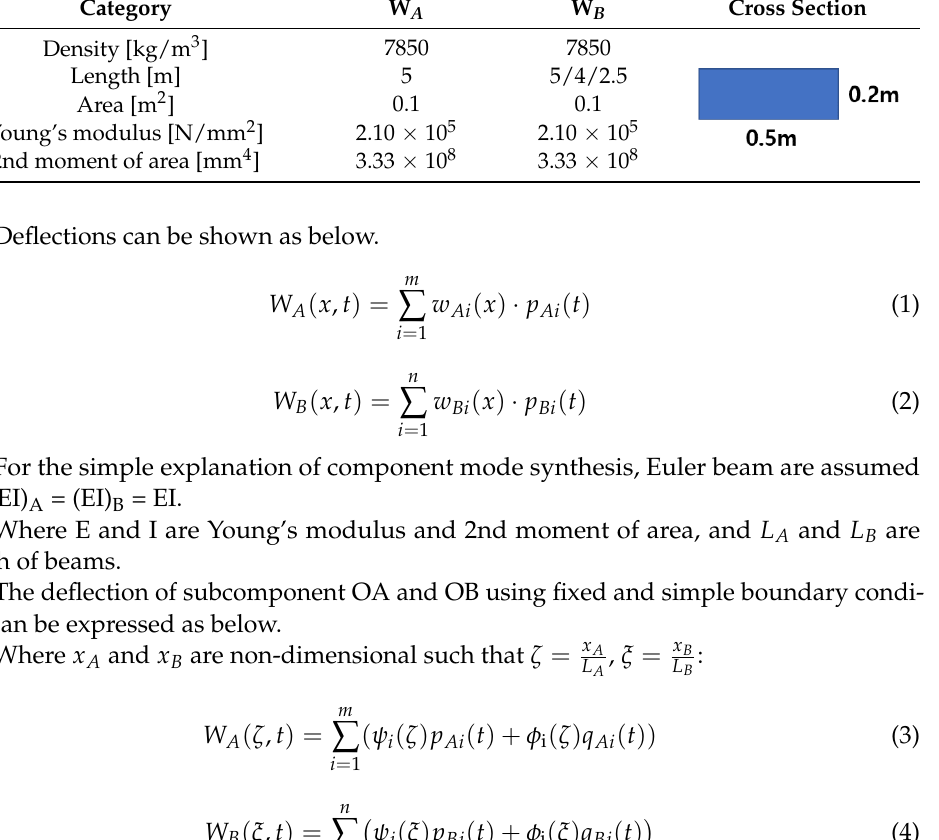
Figure 1. Structure model of two section type connected beam. ( a ) Simplify model; ( b ) finite ele- ment analysis (FEA) Model. Table 1. Properties and cross section of model. Table 1. Properties and cross section of model. category 𝐖 Category